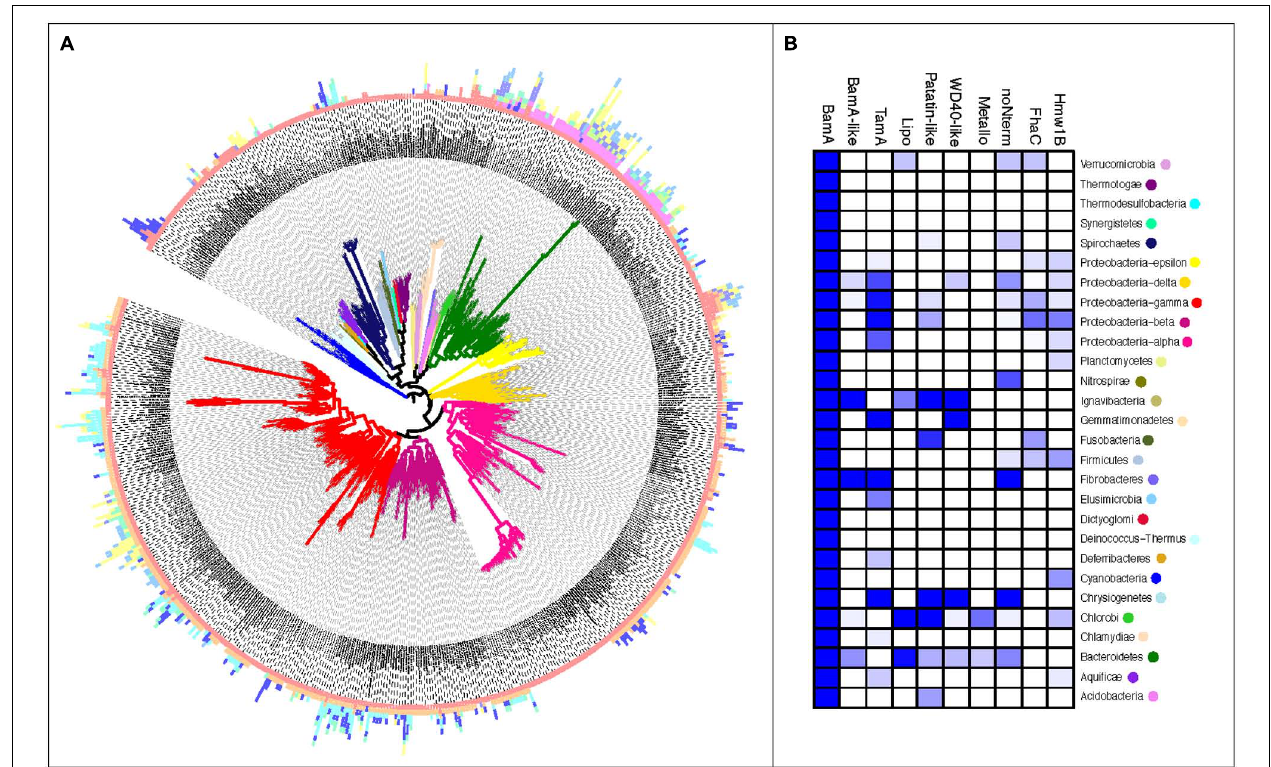
FIGURE 3 | The uneven distribution of Omp85/TpsB subgroups by taxa. (A) Sequences of the Omp85/TpsB protein subfamilies are represented by bars plotted to the respective taxa in the guidance tree. Length of the bar indicates numbers of gene copies, bar color indicates the Omp85/TpsB subfamilies as in Figure 1 , branch color indicates